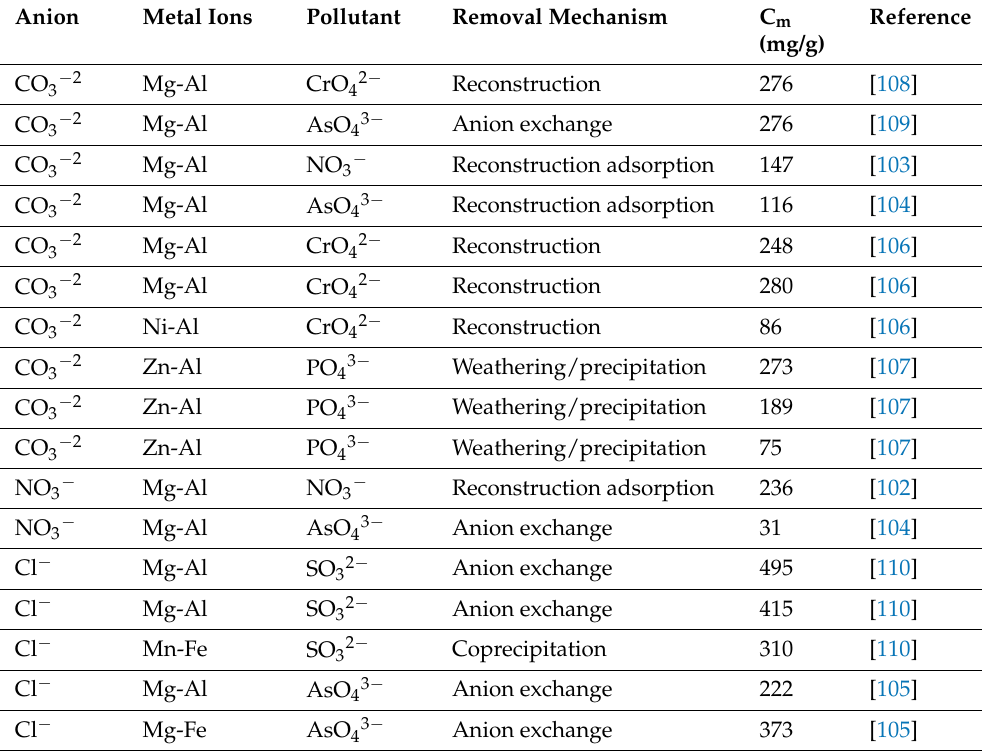
Table 1. LDH materials: mechanisms proposed and maximum removal capacity (Cm) proposed by various research